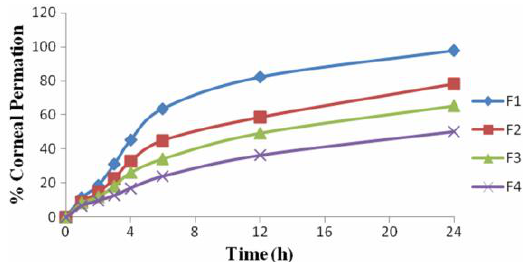
Figure 1. Cumulative % drug release versus